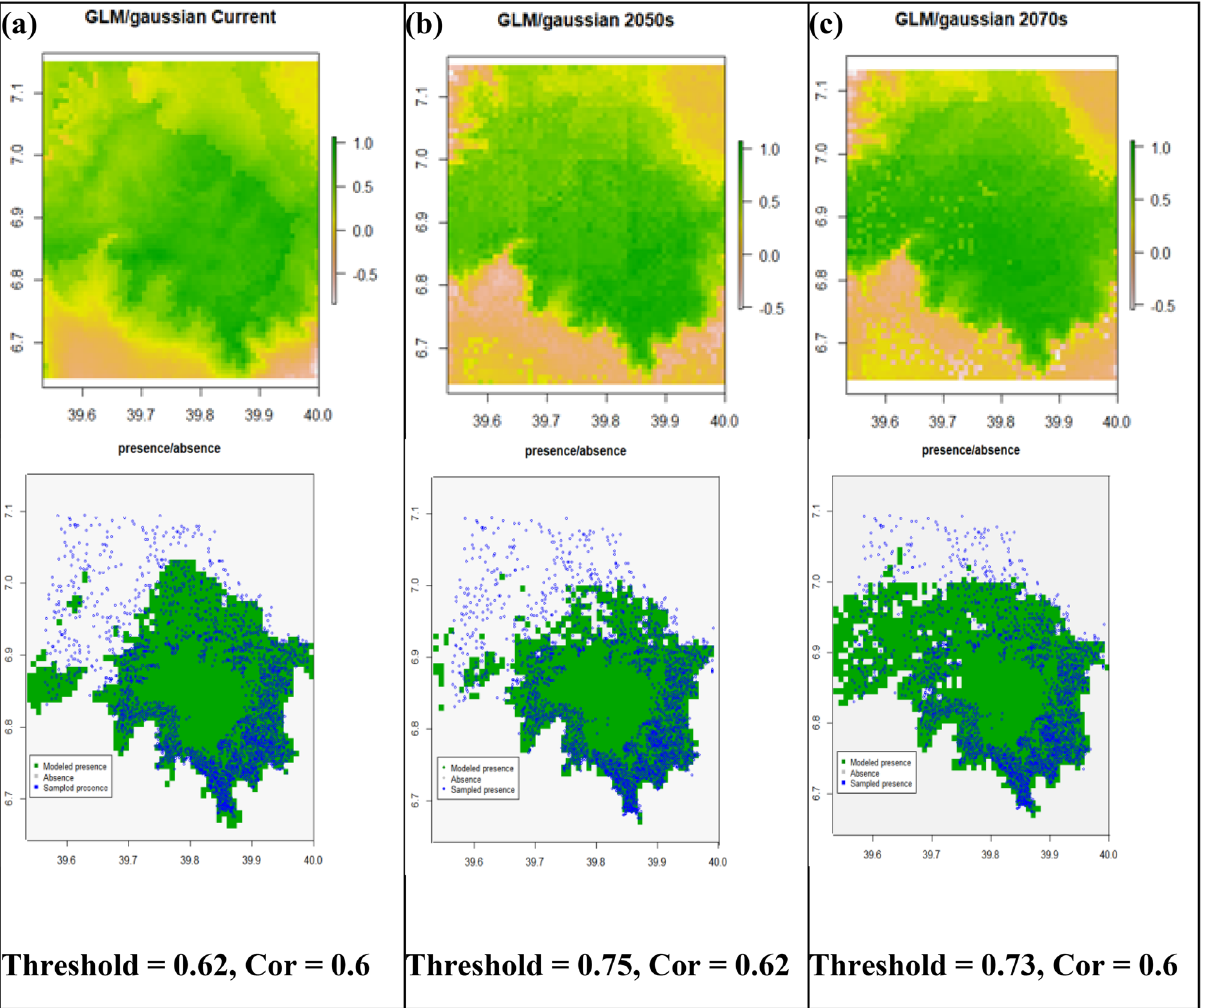
Figure 7. Generalized Linear Model’s (GLM’s) prediction maps of probability of Erica occurrence for current, future 2050s and future 2070s, and their respective presence/absence maps compared with sampled presence sampling points. A gray area represents absolute absence (unsuitable habitat), green indicates modeled presence (suitable habitat), while blue circles represent sampled presence